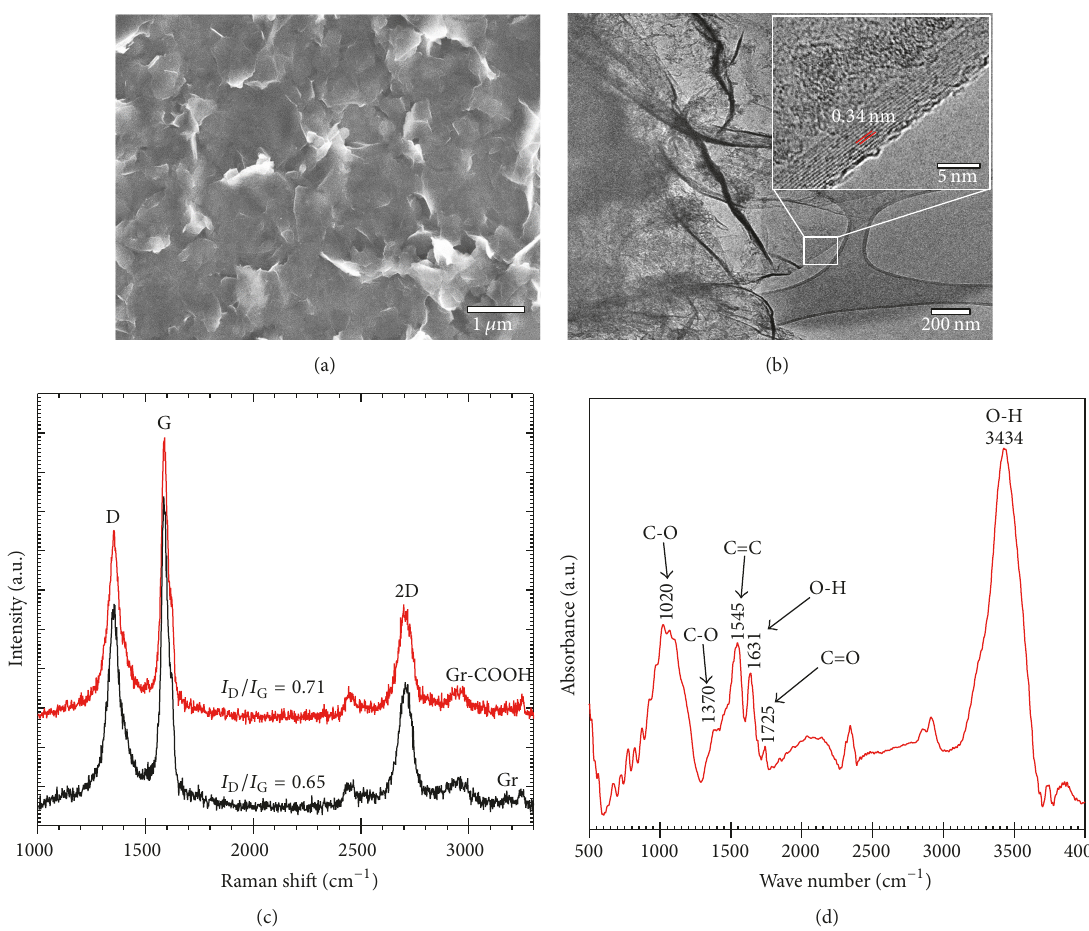
Figure 2: (a) SEM image, (b) TEM image, (c) Raman spectra, and (d) FTIR spectra of Gr-COOH.